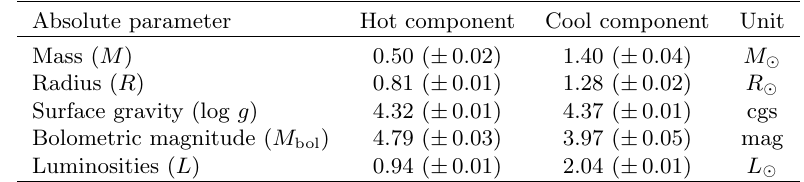
Table 7. Absolute physical parameters for BB Peg obtained by the simultaneous analysis of the light and radial velocity